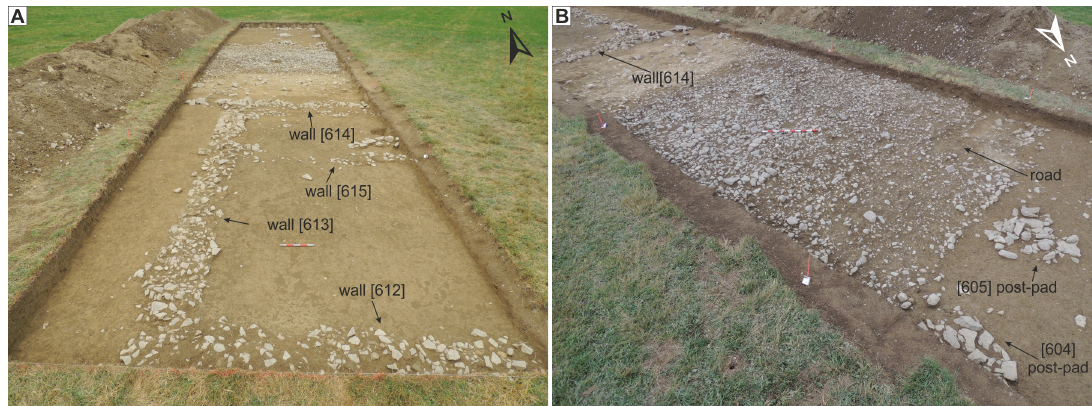
Figure 17. Photographs of the archaeological remains encountered at the trench E. ( A ) Stone basement of a rectangular building; ( B ) The road and some of the post-pads. Photographer: Antonietta